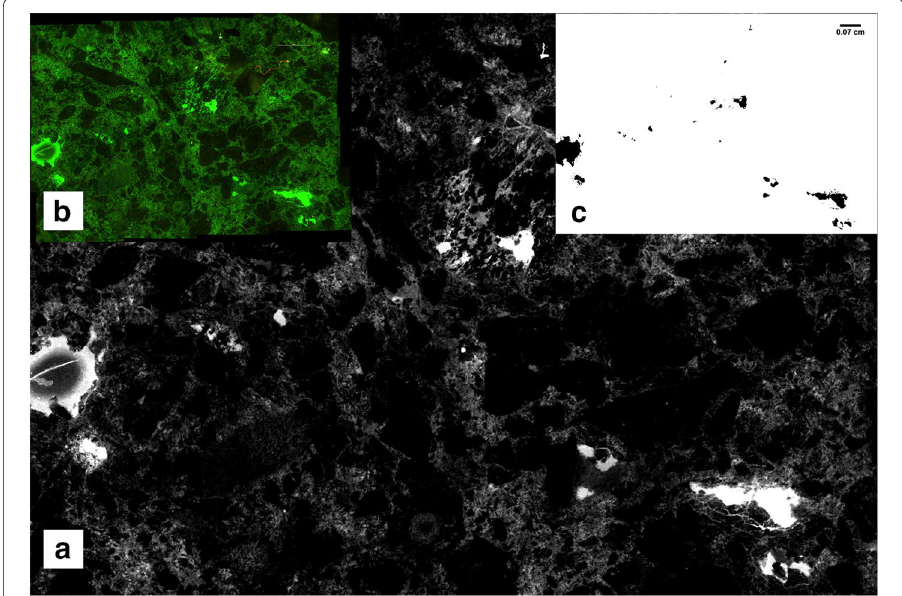
Fig. 3 a Thin section of sample with pore-dominated porosity and only one minor fracture visible; b thin section under fluorescent light; c TS3 binary image with the connected voids in black and unconnected voids and minerals in white. In the bottom right of the image, there are visibly fewer fractures surrounding the vug in c than in a due to the white intensity selected for the image. If the intensity was set to allow for